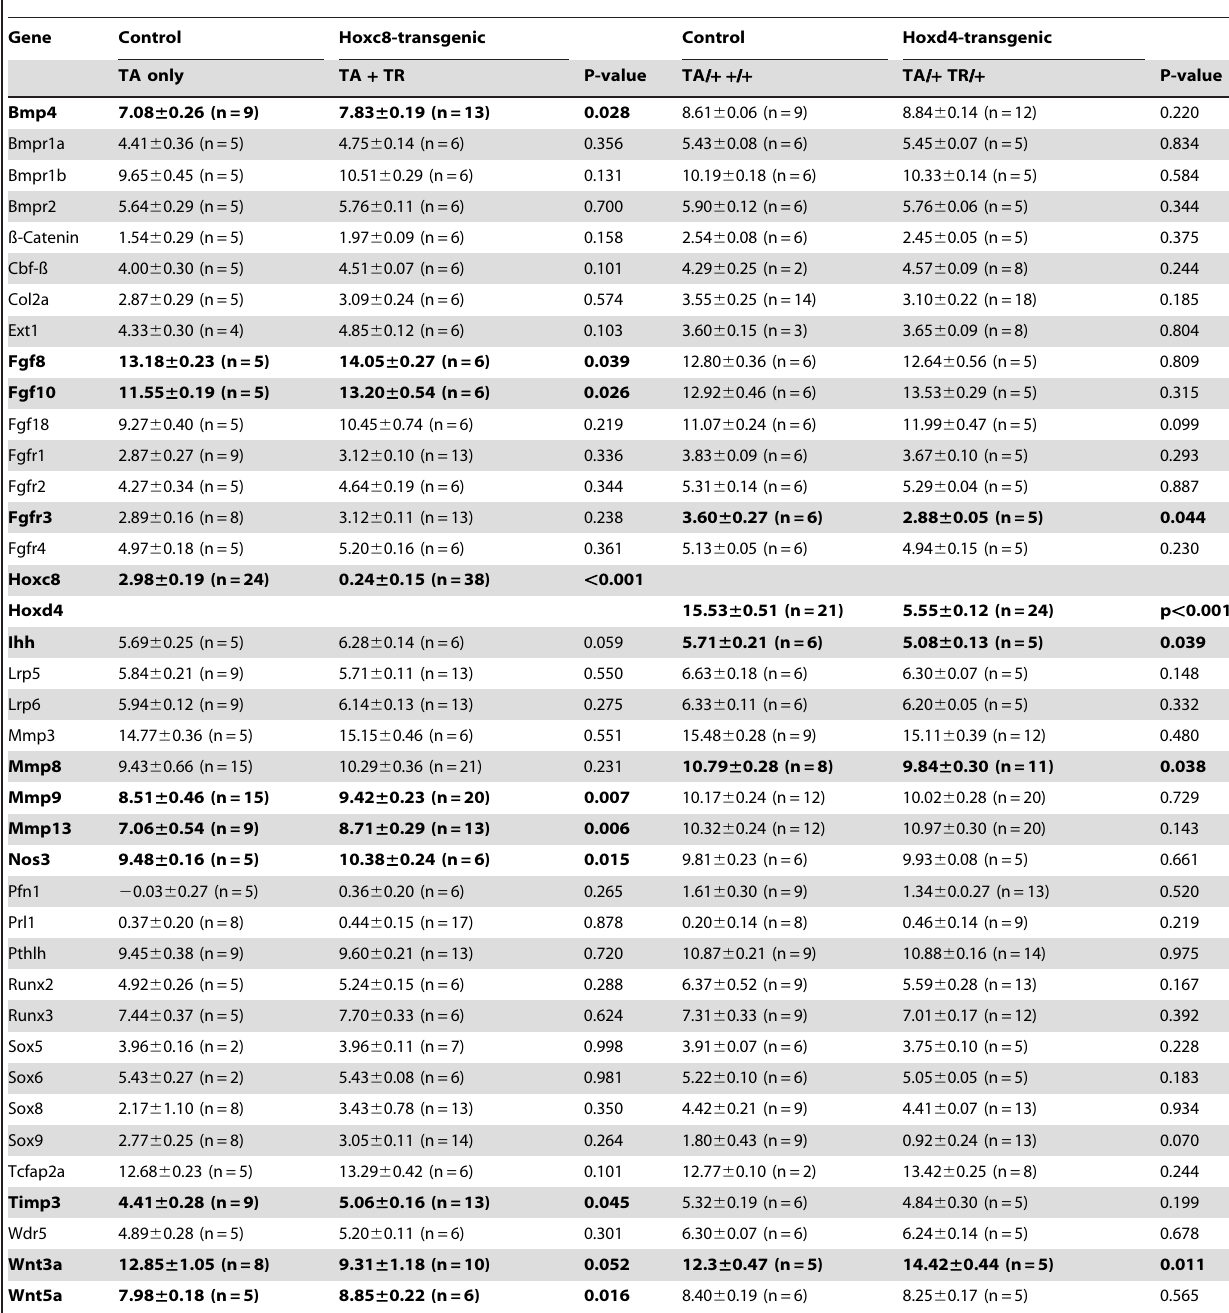
Table 2. Gene expression in Hoxc8 and Hoxd4 transgenic animals normalized to